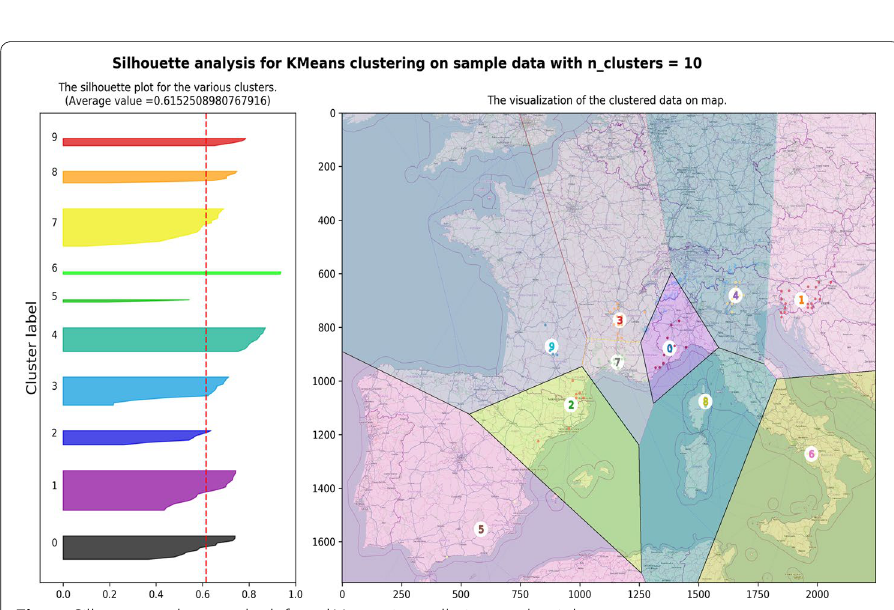
Fig. 5 Silhouette values on the left and Voronoi tessellation on the